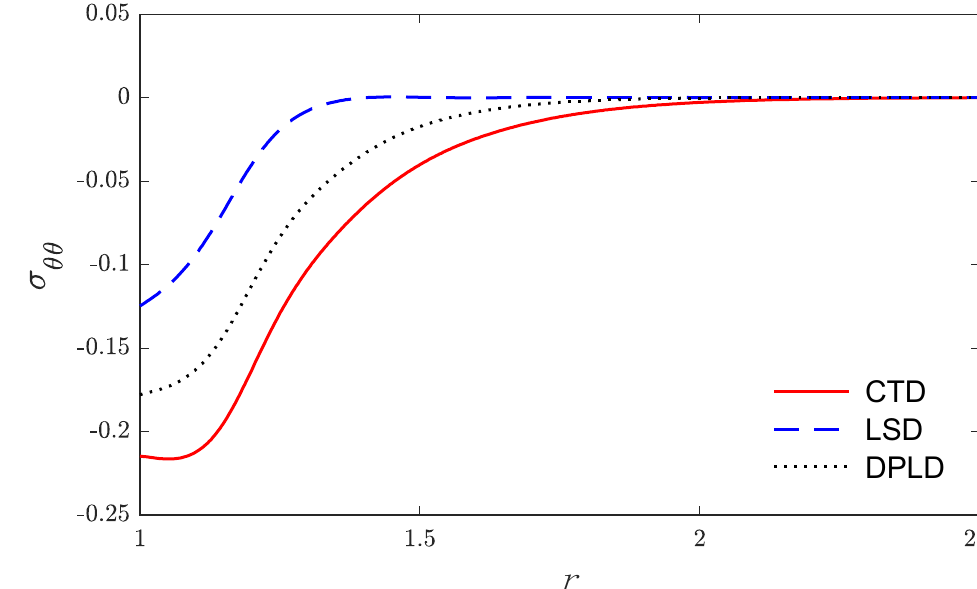
Figure 4. The redial stress variations 𝜎 (cid:3045)(cid:3045) along the redial distance 𝑟 for three models.